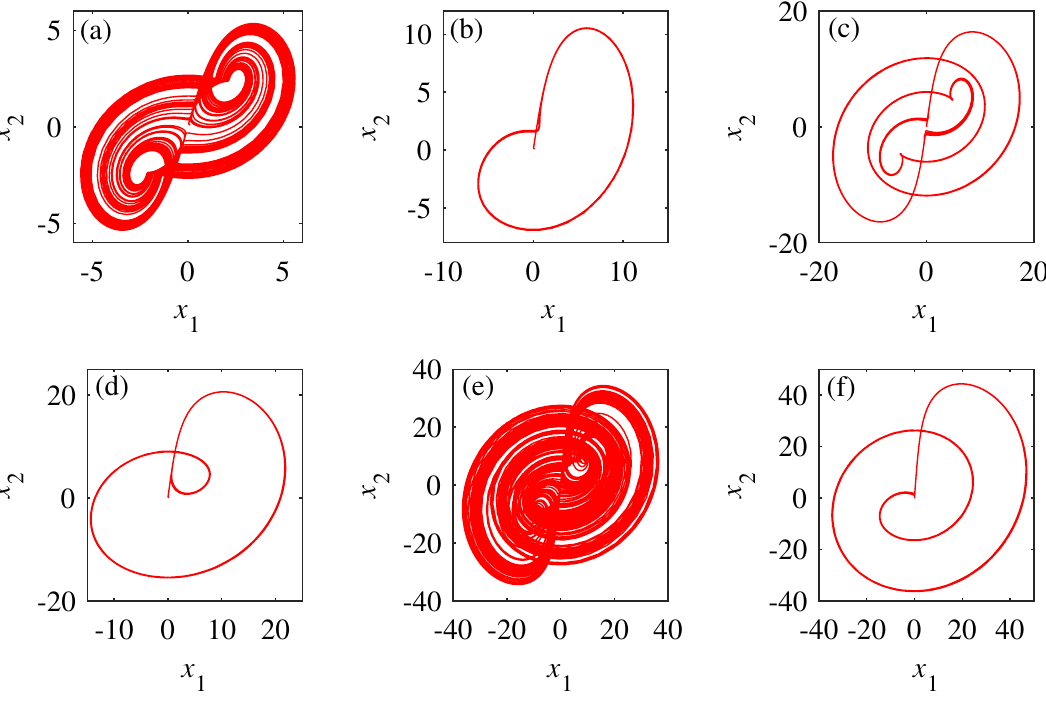
Figure 3. The phase diagrams of system (2) when the initial value is (0.1,0.1,0.1) and the unknown parameters are selected with different values. ( a ) The system phase diagram when a =3. ( b ) The system phase diagram when a =4.5. ( c ) The system phase diagram when a =6. ( d ) The system phase diagram when a =10. ( e ) The system phase diagram when a =6. (f) Phase diagram of the system at a